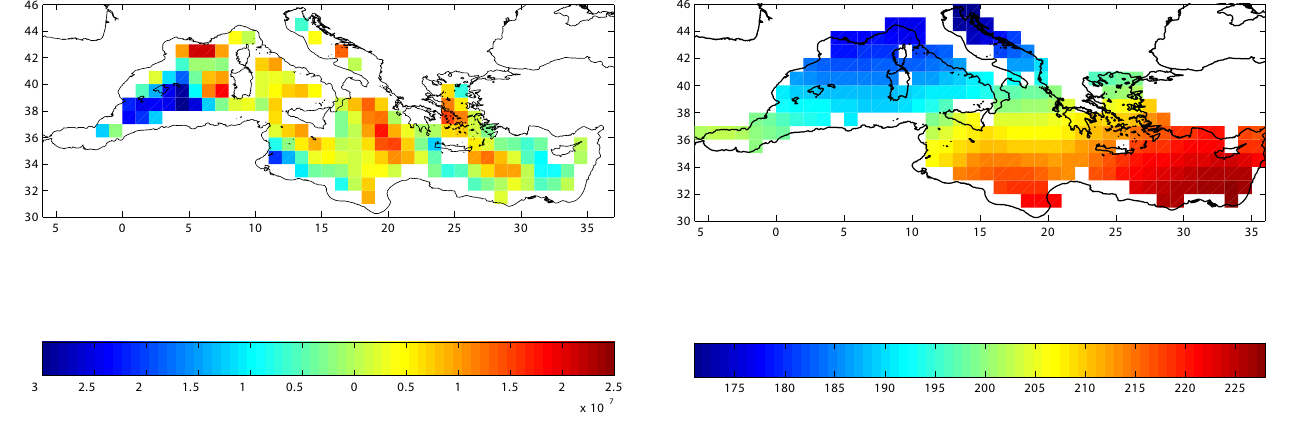
Fig. 2. Wind stress curl difference between February and August. Units are Nt/m 3 .